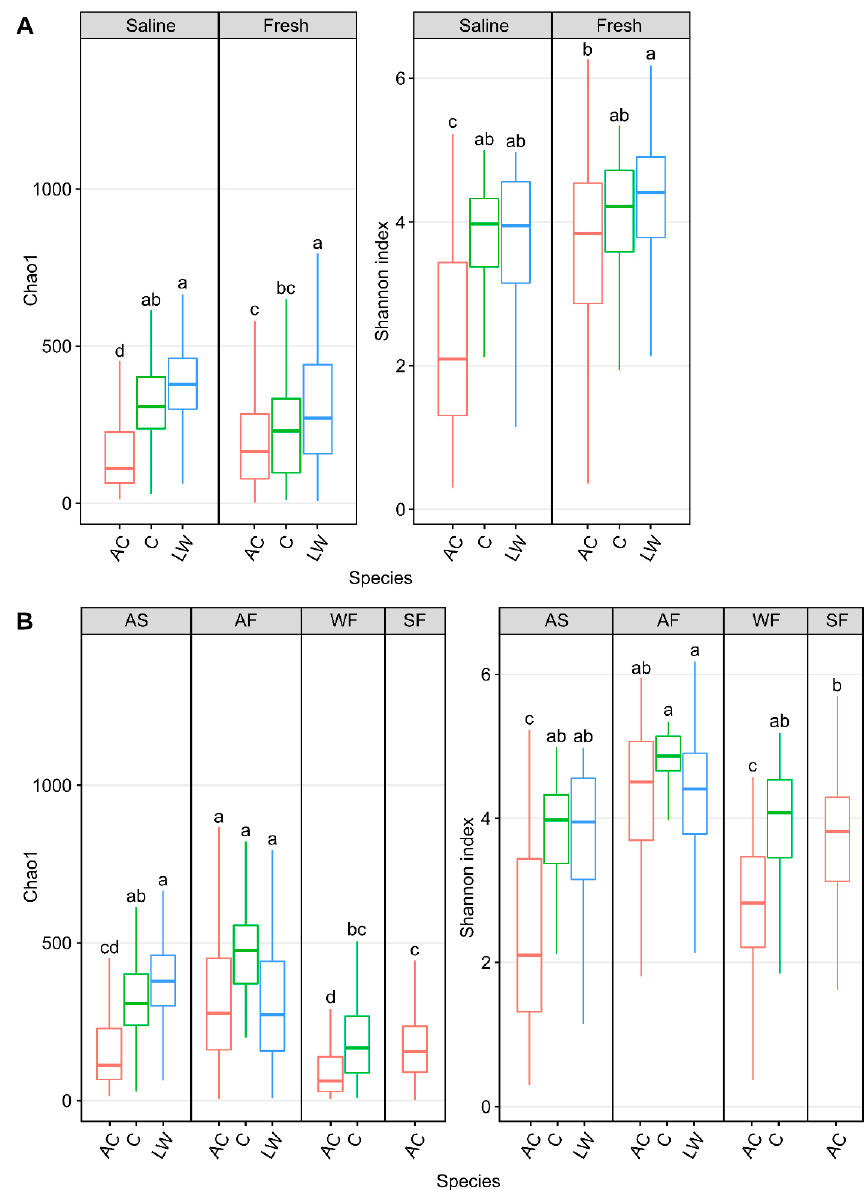
Figure 6. Alpha diversity metrics, Chao1 and Shannon diversity, measuring skin microbial community abundance and diversity, respectively, of Arctic char (AC) and Coregonus species complex cisco (C) as well as lake whitefish (LW) in ( A ) saline and freshwater and ( B ) in different seasonal habitats (abbreviated as described in Figure 3 and situated above each graph). Lower case letters within each individual graph display significantly different ( p < 0.001) groupings as determined by one-way ANOVA. It should be noted that data from lake whitefish and cisco (Hamilton et al., 2023 [43]) are presented here for comparison with the Arctic char calculated diversity.